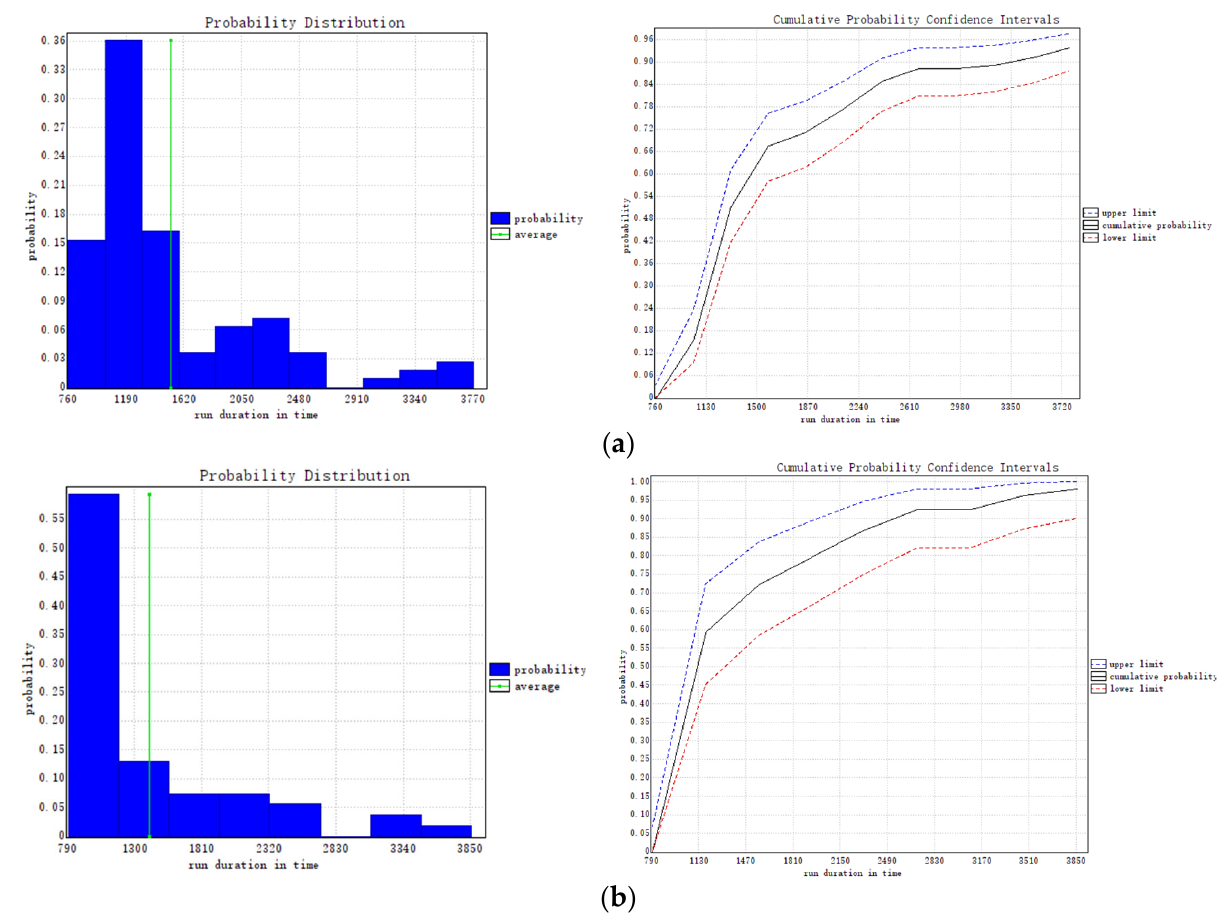
Figure 13. Probability distribution and cumulative probability confidence intervals of transmission accuracy on the CAN bus. ( a ) The probability of successful transmission under the FMA-RNN without optimization. ( b ) The probability of successful transmission under the FMA-RNN after optimization.